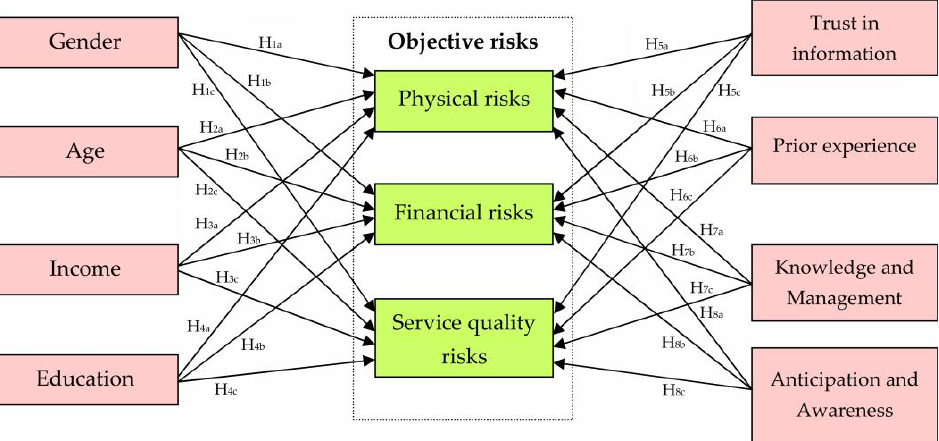
Figure 2. Proposed model of research with defined hypotheses.